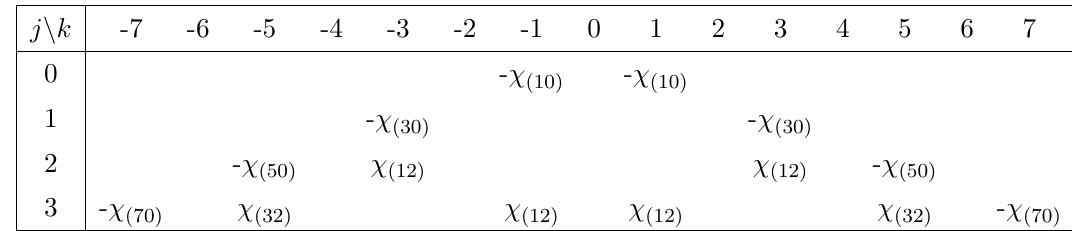
( m ) in the series expansion of (cid:24) 1 ; Sp(2) Sp(2) j;k